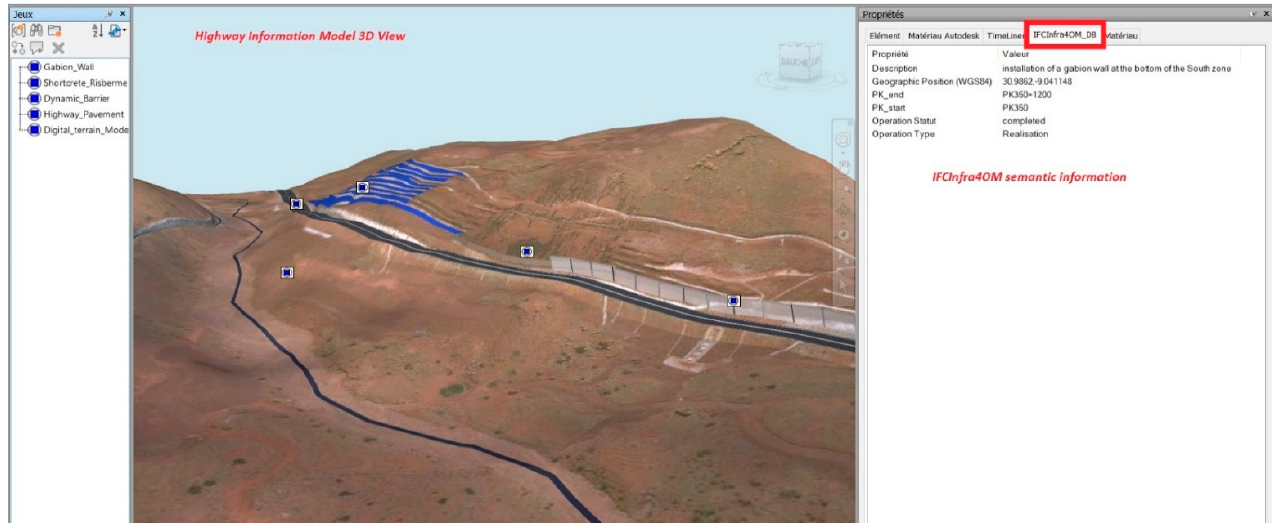
Figure 13. Use Case 1: 3D Visualization of the Highway O&M Information Model (Navisworks software).